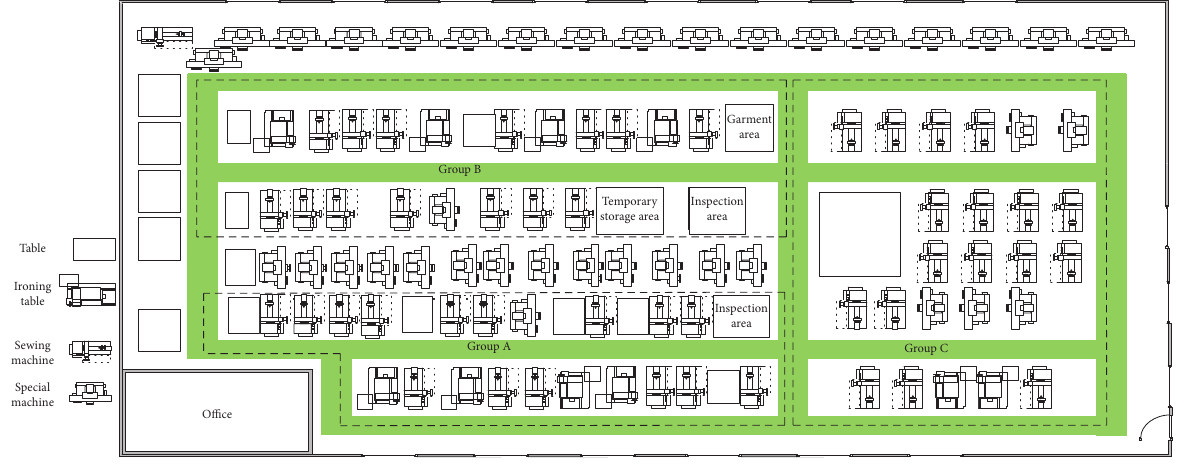
Figure 5: Layout of the women’s wear workshop.